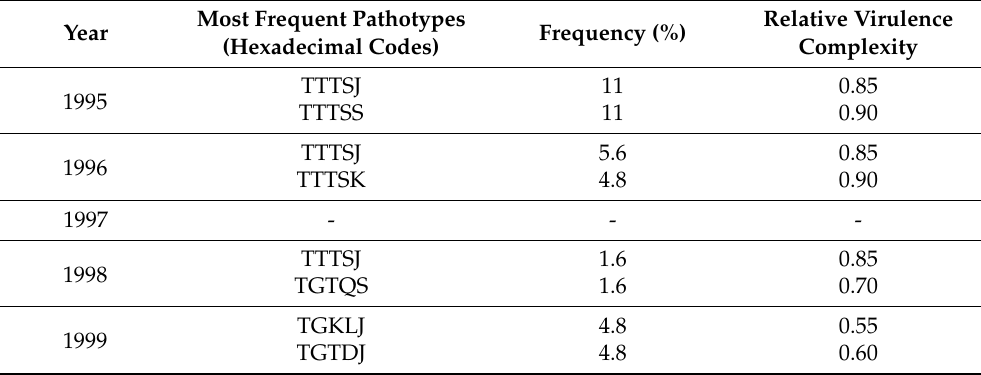
Table 3. The most frequent pathotypes of Blumeria graminis f. sp. tritici collected during